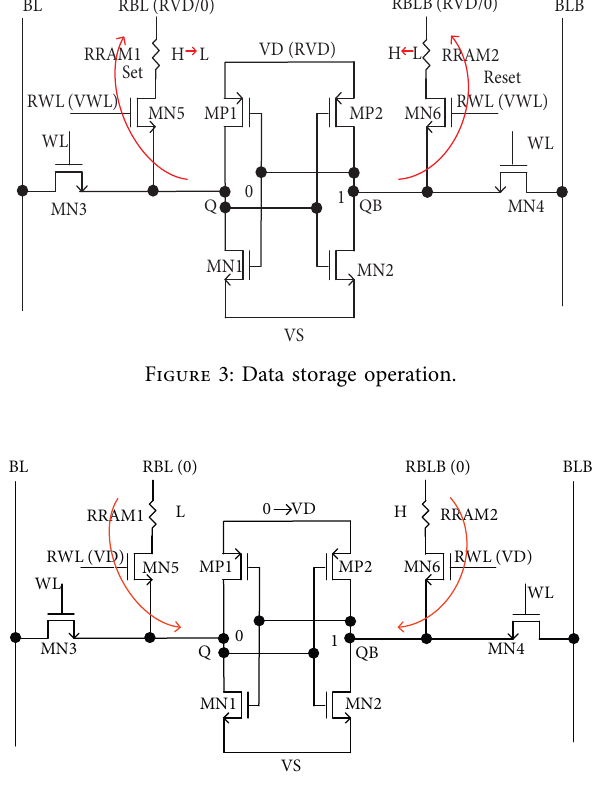
Figure 4: Data restoration operation.